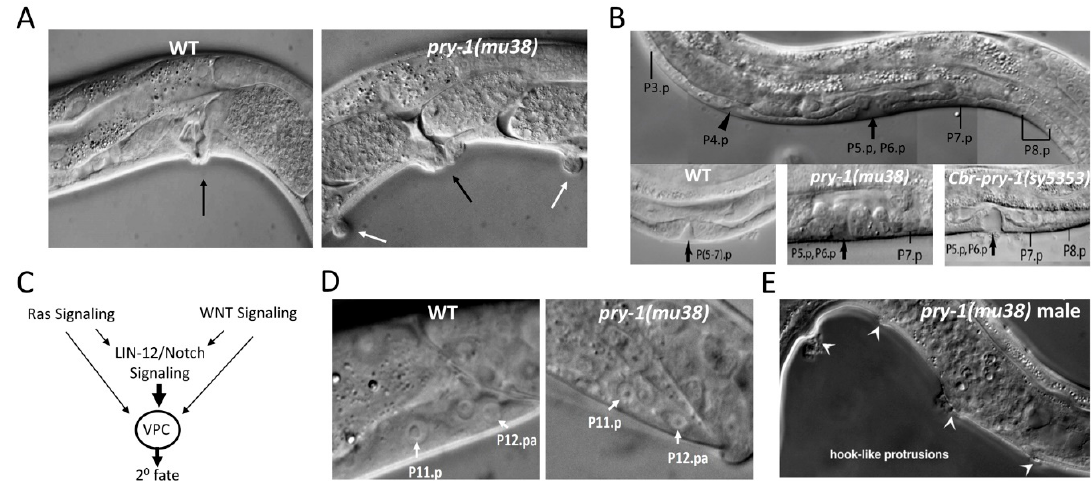
Figure 7. pry-1 is necessary for the development of P lineage cells. ( A ) Multiple vulva-like protrusions seen in a pry-1(mu38) animal (white arrows). Black arrows mark the main vulva. WT, wild-type ( B ) VPC fates are defective in pry-1(mu38) animals. Unlike the wild-type, where the progeny of P(5-7).p give rise to the vulva, P7.p in pry-1(mu38) and P7.p and P8.p in Cbr-pry-1(sy5353) animals remain unfused (panel adapted with permission from [122]). ( C ) A proposed model of interactions between WNT, Ras, and Notch pathways to specify the 2 0 fate of induced VPCs. ( D ) pry-1(mu38) mutants show an extra P12.pa-like cell in the place of P11.p. The wild-type P11.p has a large nucleus and a nucleolus compared to P12.pa, which is noticeably smaller. In the case of bar-1(ga80) mutants, an opposite phenotype is seen, i.e., two P11.p-like cells [156]. ( E ) Ectopic hook-like structures in pry-1 mutant males are marked by arrowheads (panel adapted with permission from [157]).